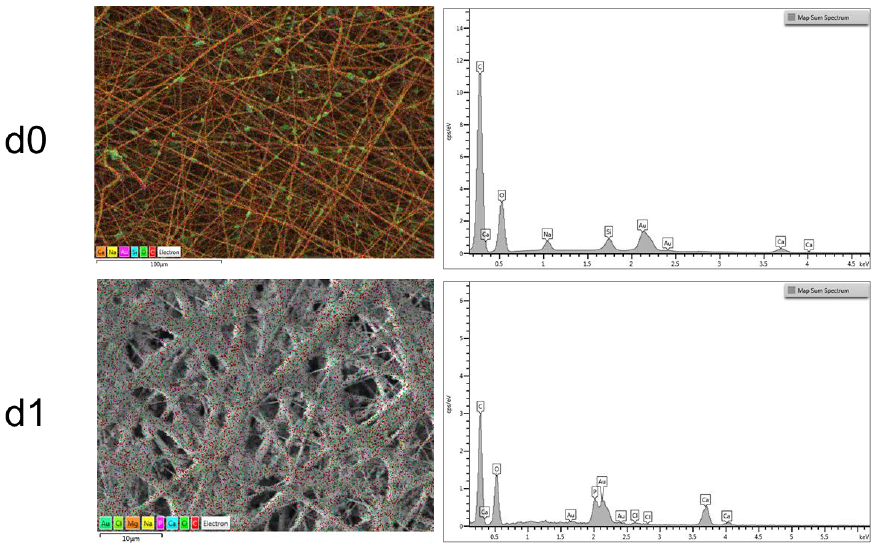
Figure 7. SEM micrographs of PCL and PCL-bioactive glass (BG) composite electrospun mats before immersion in simulated body fluid (SBF) solution (PCL d0 and PCL-BG d0 ( A – C )) in the first row; after one day of immersion in SBF (PCL d1 and PCL-BG d1 ( D – F )) in the second row; after four days of immersion in SBF (PCL d4 and PCL-BG d4 ( G – I )); and after seven days of immersion in SBF (PCL d7 and PCL-BG d7 ( L – N )).